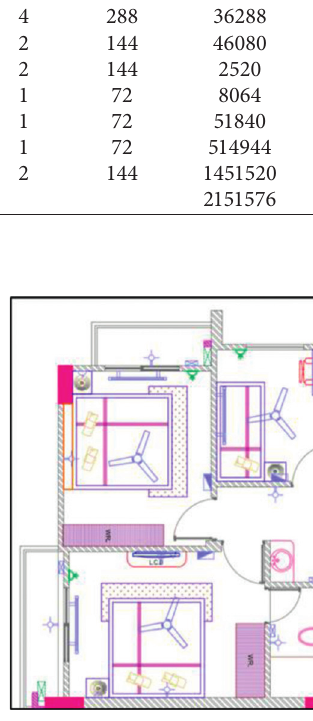
Figure: 7: 3BHK floor